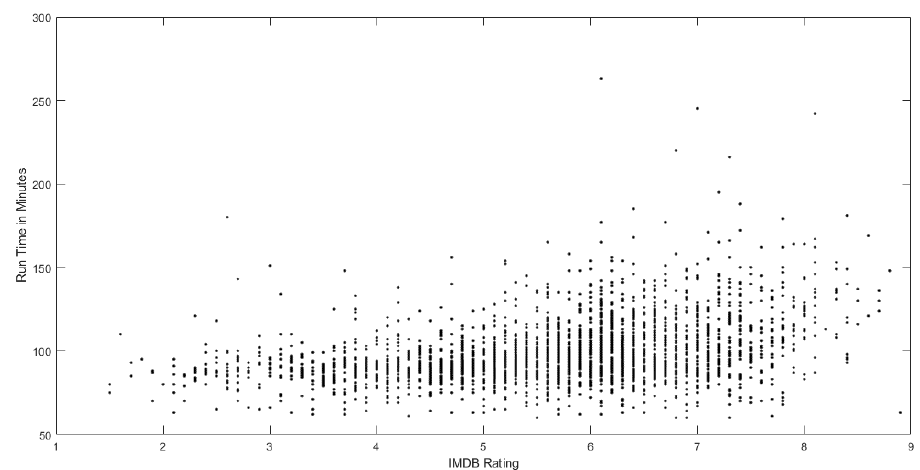
Figure 4. Relationship between IMDB Rating and Run Time in Minutes.